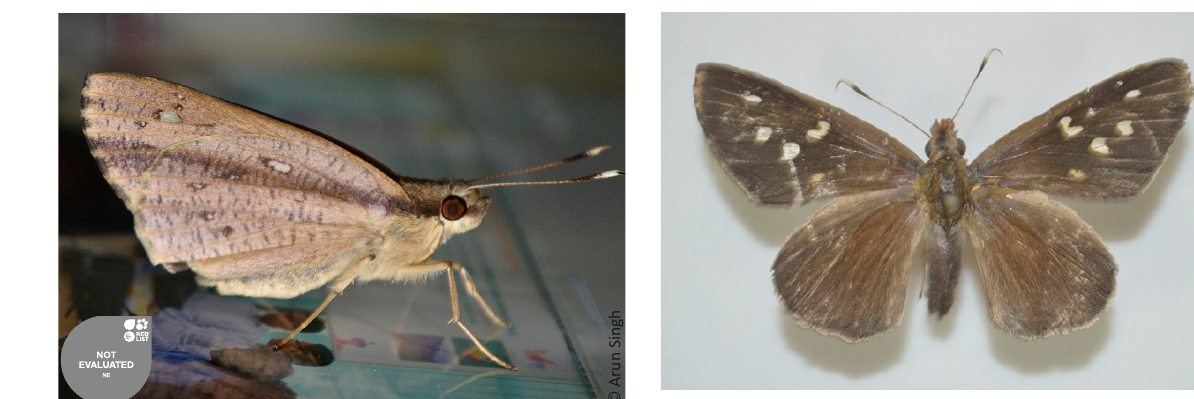
Image 1. Veined Palmer Hidari bhawani (side view of underside; male; 26.iii.2014)